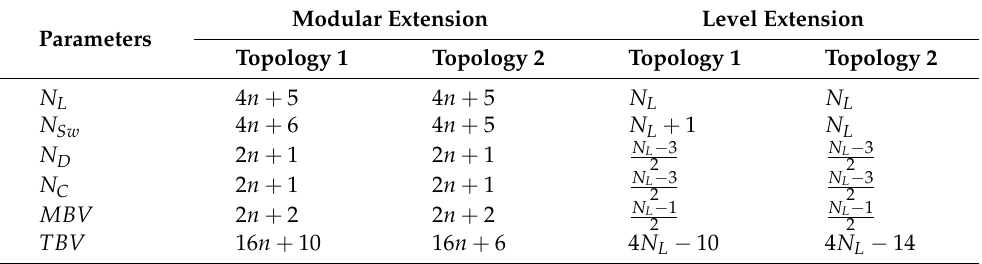
Table 4. Generalized Formula for Extended Topology.